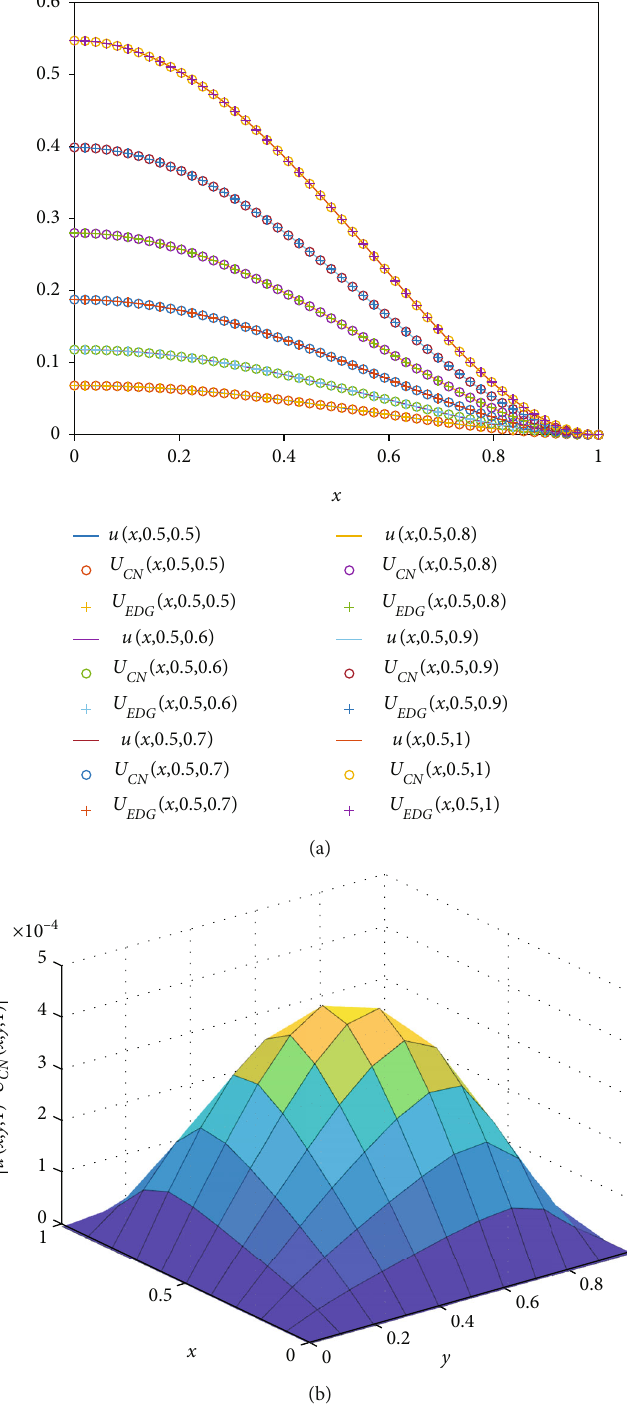
Figure 3: The exact, Crank – Nicolson, and EDG solutions in di ff erent values of t and y = 0 : 5 (a) and the absolute error of Crank – Nicolson method at T = 1 (b) of Example 13 for Δ t = 0 : 01 , Re = 100 , N = 49 , and α = 0 : 5